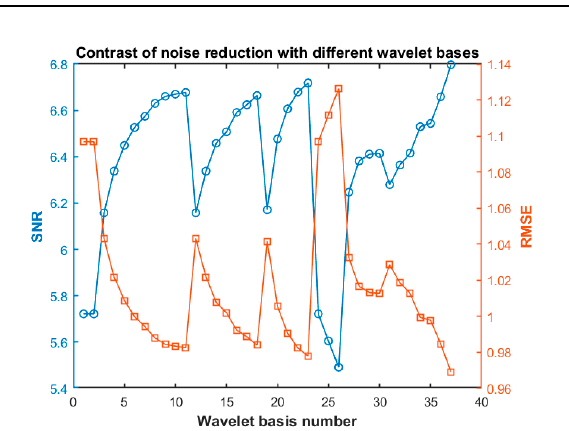
Figure 3. Signal to noise ratio (SNR) and root mean square error (RMSE) of noise reduction for the different wavelet bases.